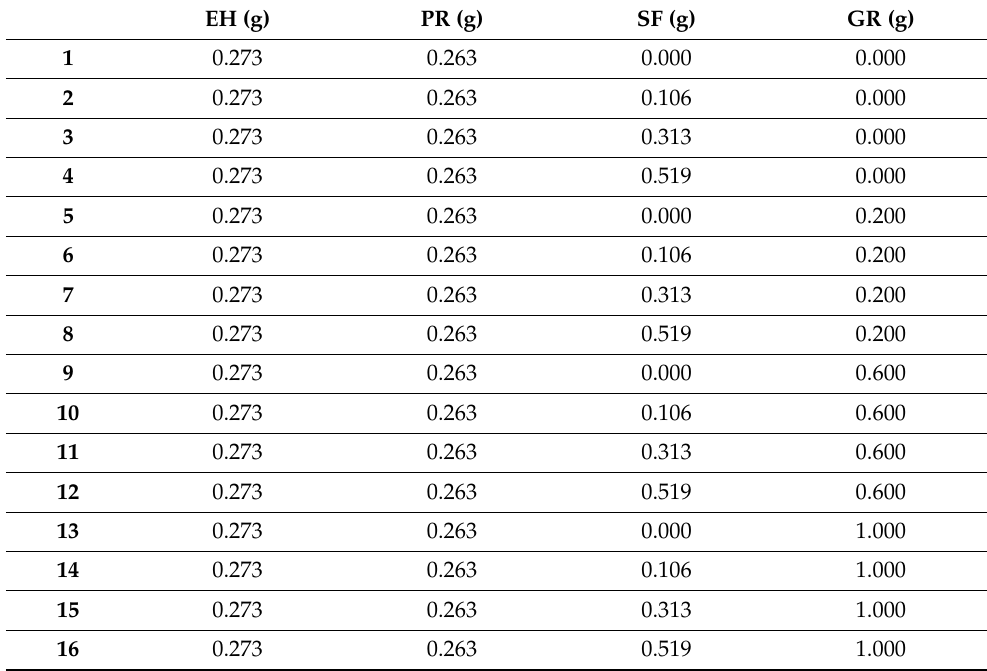
Table 1. Combined doses of the herbal extract used to confirm the synergistic